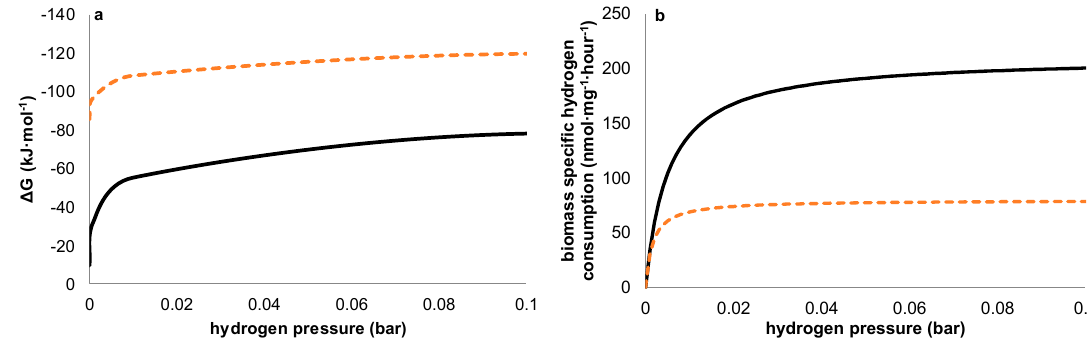
Figure 6. Shows the effect of variable hydrogen pressures on the competition between acetogens and methanogens both in terms of ( a ) Gibbs free energy of reaction [12]; and ( b ) biomass specific substrate consumption rate (Monod parameters for modelling growth were taken from reported values in Kotsyurbenko et al. [21]). As can be seen, methanogens have a thermodynamic advantage over homoacetogens throughout the whole domain. This thermodynamic advantage is reflected in the growth curves through the hydrogen affinity ( K s ) for methanogens in general being lower than for acetogens. However, acetogenesis achieves higher conversion rates at higher hydrogen partial pressures ( µ max ) compared to methanogenesis, rendering hydrogen pressure an essential parameter to steer competition between acetogens and methanogens [21].